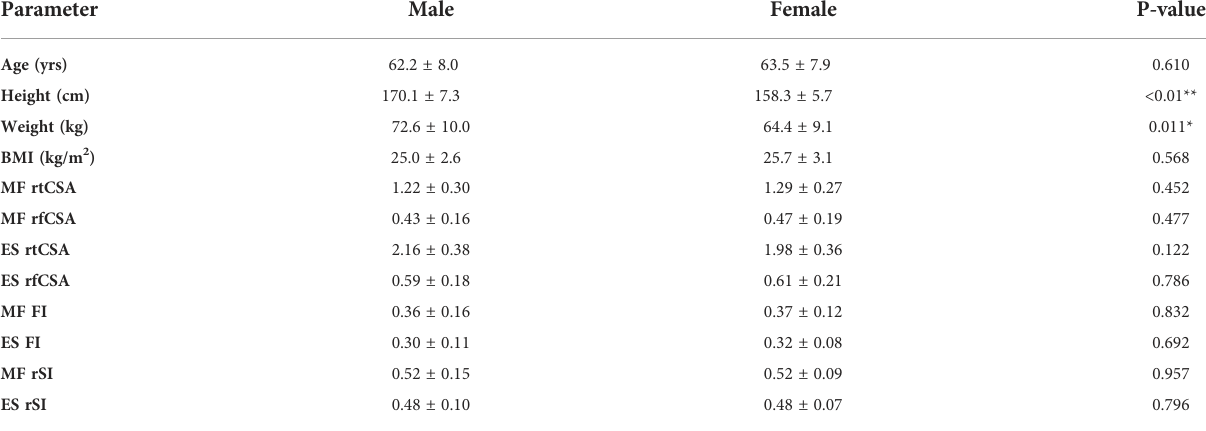
TABLE 4 Comparison of paraspinal muscle parameters between genders in patients. Parameter